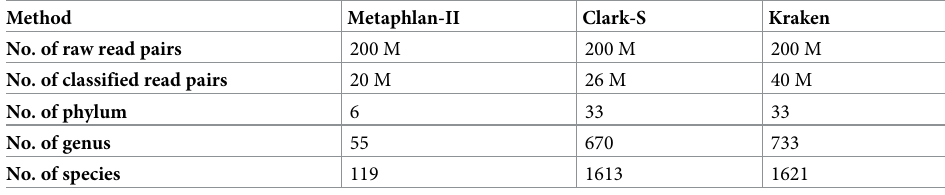
Table 1. Summary of reads used and classification results for different approaches (full